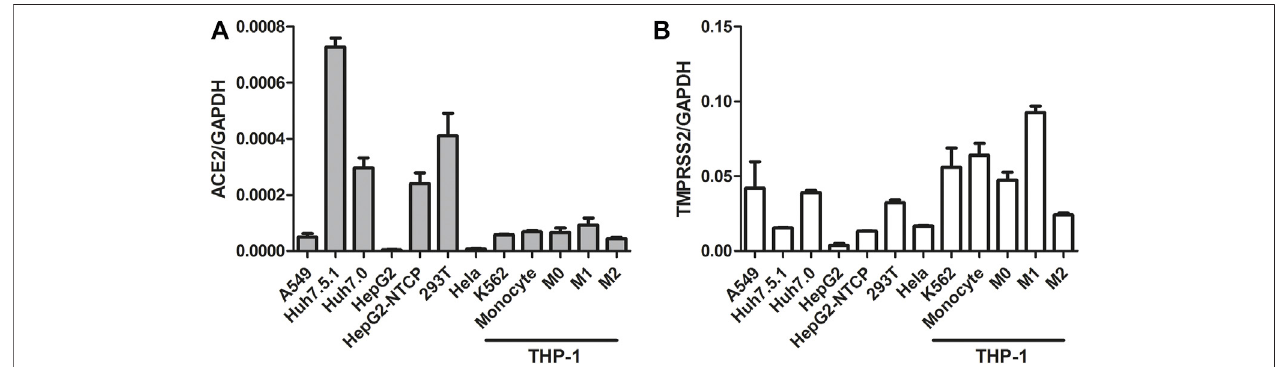
FIGURE1| ACE2andTMPRSS-2expressionindifferentcelllines.Seedcellstobe80 – 90%con fl uentin6-wellplateuntilcellswereharvestedandtotalRNAswere extracted. 1ug total RNA was applied for reverse transcription. ACE2 and TMPRSS-2 expression was assessed using real-time PCR (normalized to GAPDH). Data are presented as mean ± SD (n ≥ 3).